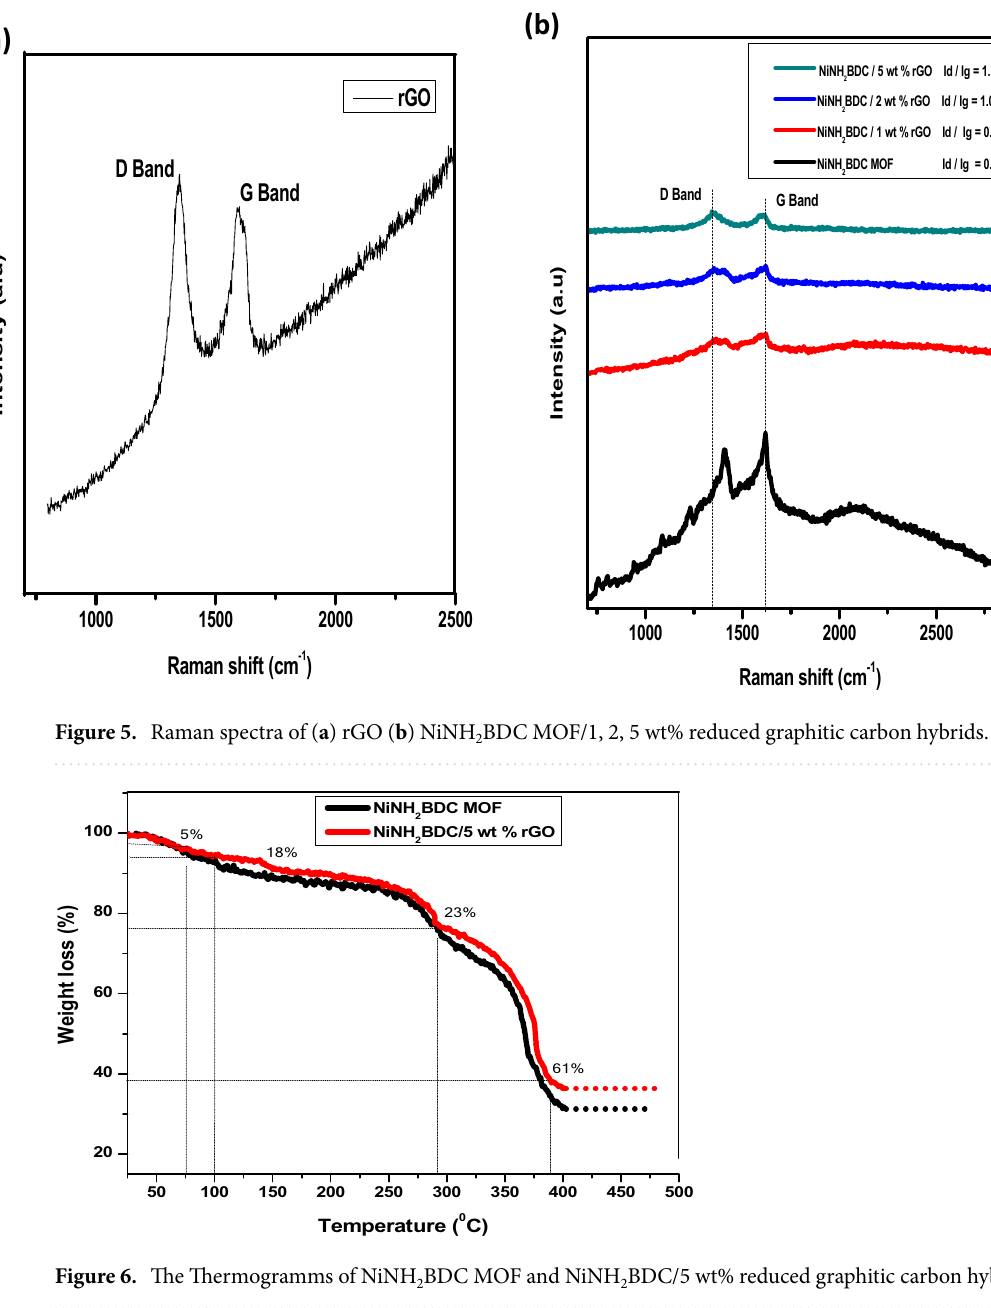
Figure 6. The Thermogramms of NiNH 2 BDC MOF and NiNH 2 BDC/5 wt% reduced graphitic carbon